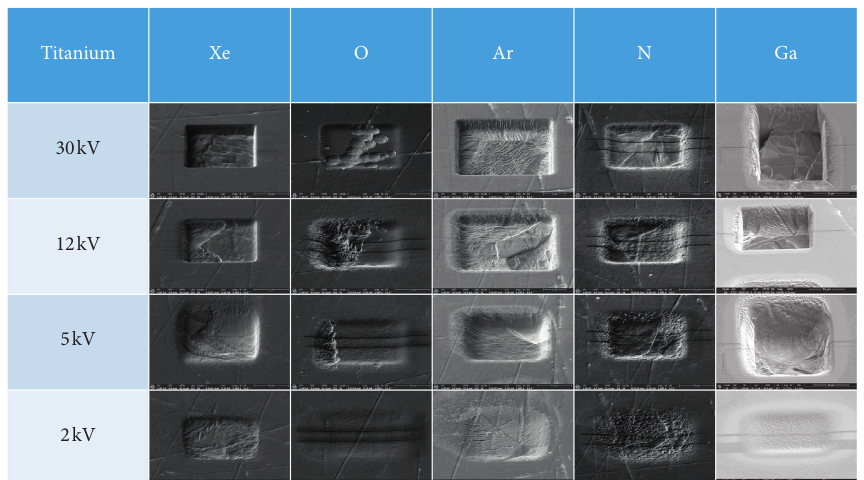
Figure 16: All images of titanium milled with different ion species at varying energies. Area is held constant at 20 µ m 2 . For beam current values, refer Table 1. All images were captured with a horizontal field width of 41.4 µ